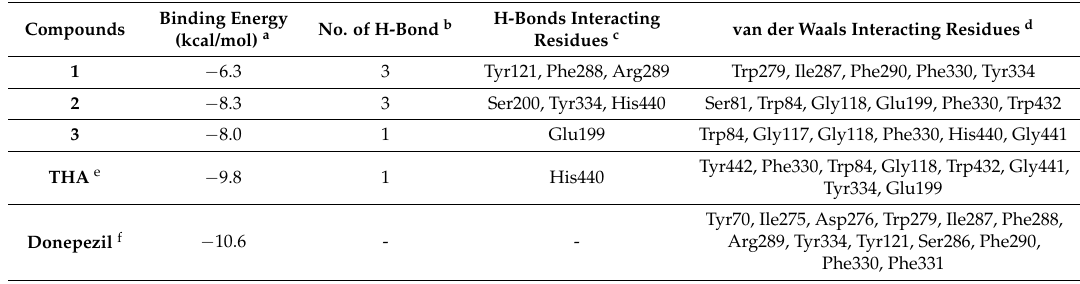
Table 2. Molecular interaction of the acetylcholinesterase active site with 1 – 3 and the inhibitors THA and donepezil.